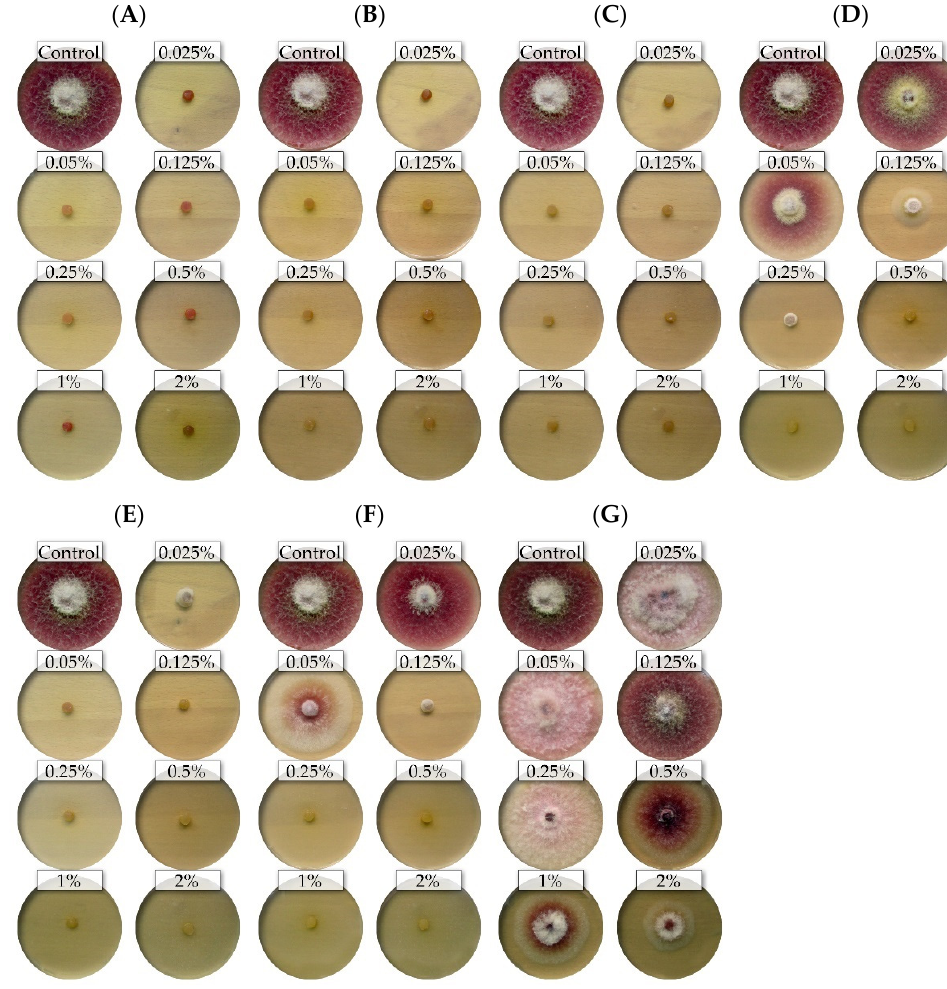
Figure 1. The effects of the different concentrations of the essential oils on the mycelial growth of the Fusarium culmorum FC2D: ( A )—thyme (T); ( B )—lemongrass (L); ( C )— Litsea cubeba (LC); ( D )—cajeput (C); ( E )—verbena (V), ( F )—TTO; ( G )—grapefruit (G) (light background).